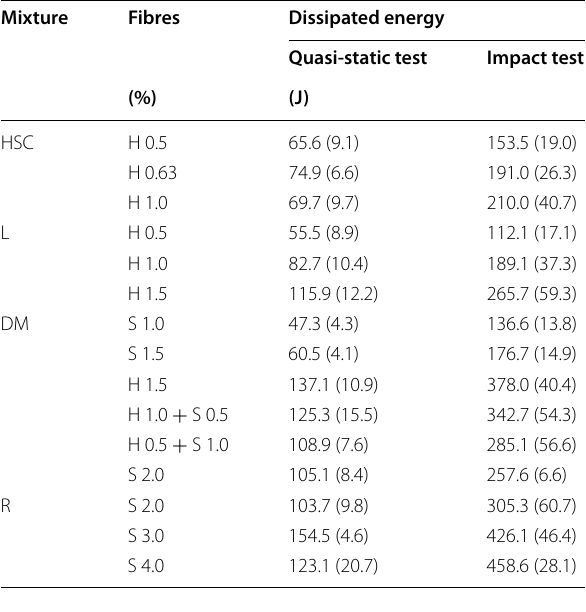
Table 3 Dissipated energies for both experiments. Numbers in brackets are the standard deviations.